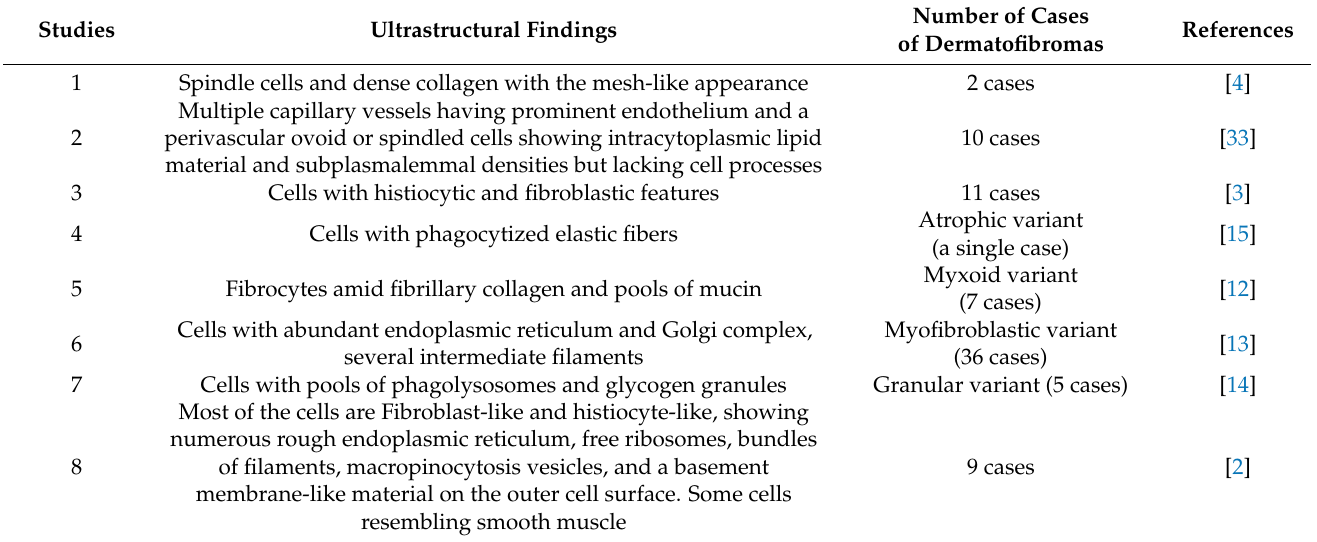
Table 2. Data from individual studies about ultrastructural features of